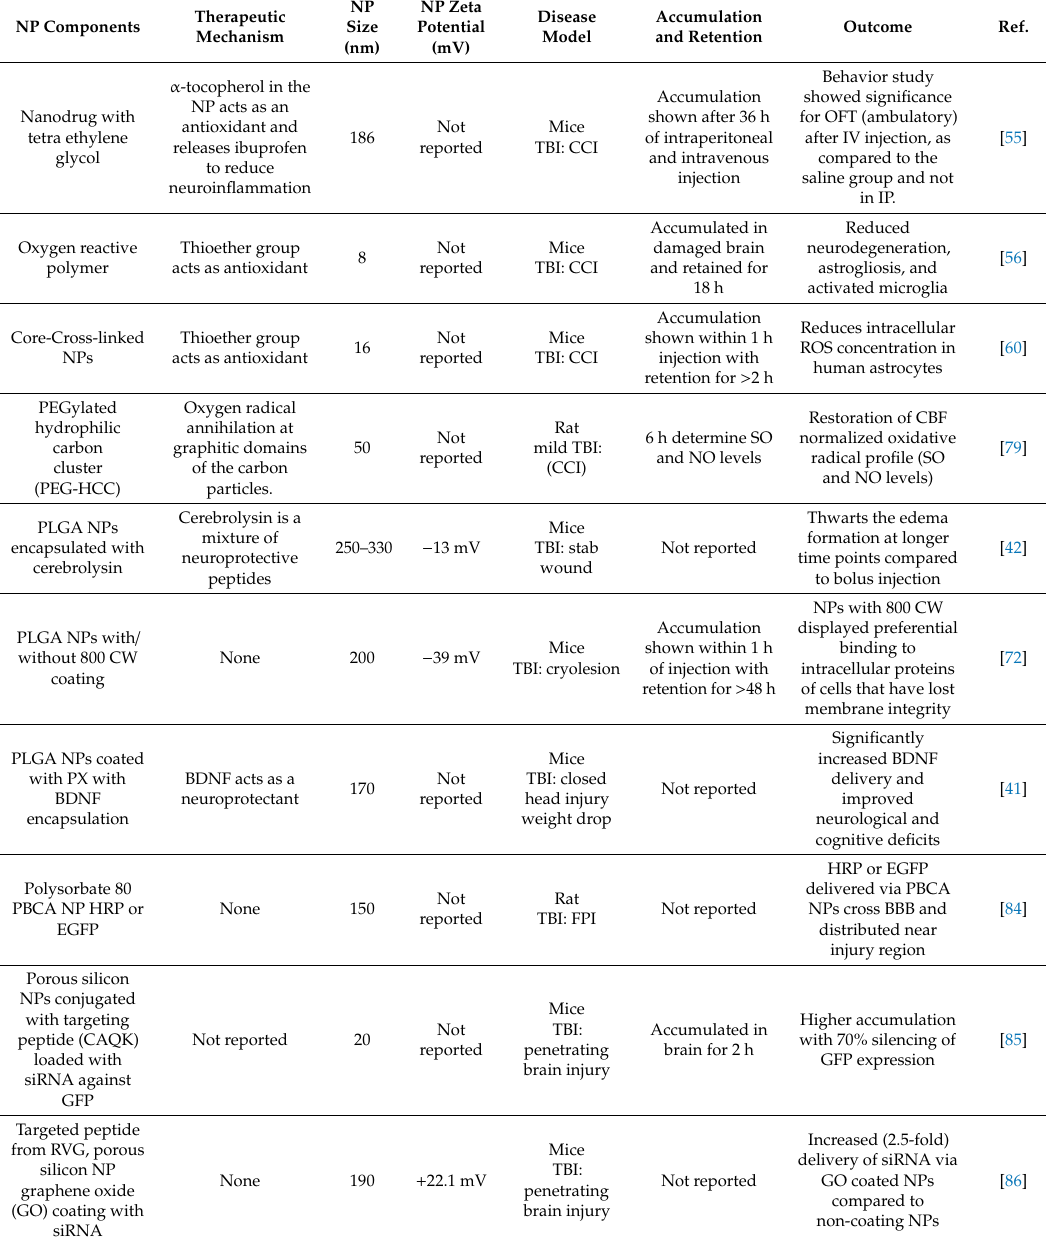
Table1. Summaryofvariousnanoparticlesforpassiveandactivedeliveryforbraintraumaapplications a . NP